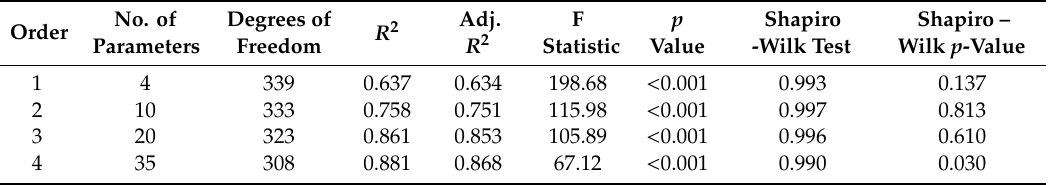
Table 4. The table of fit statistics for polynomial models from first to fourth order fitted to area under the receiver operating curve (AUROC) data.